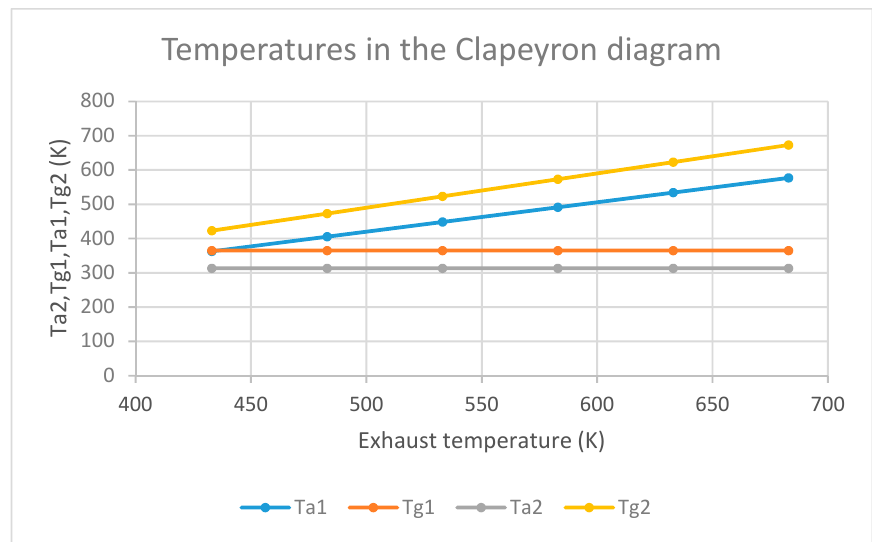
Figure 5. Bed temperature versus exhaust temperature.